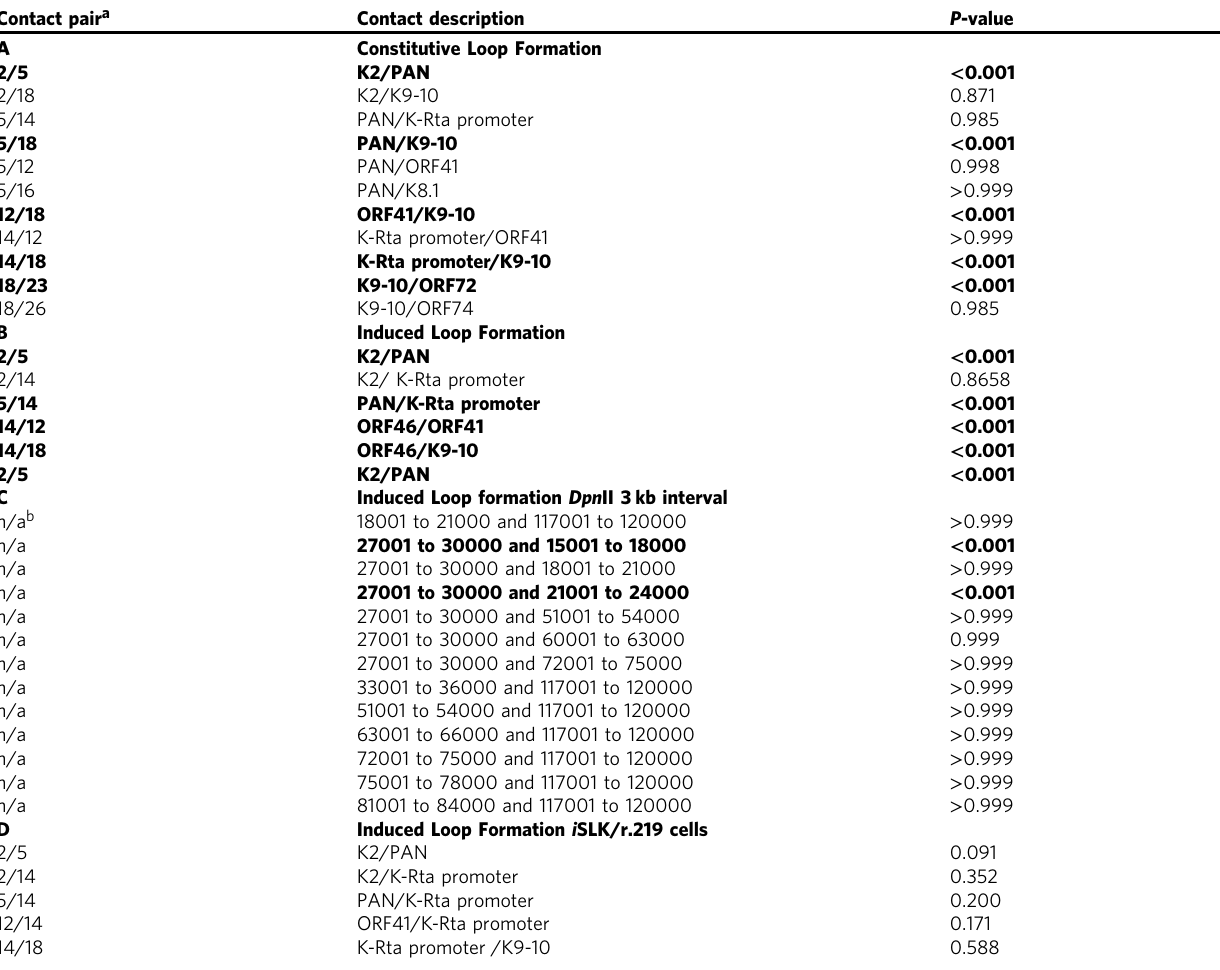
Table 2 Statistical analysis of contacts Contact pair